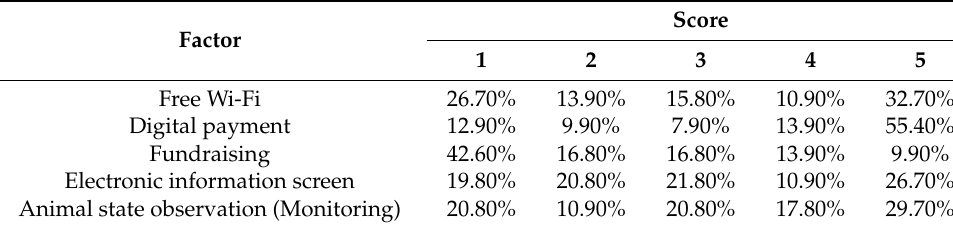
Table 13. Results (Performance) of the second-level questionnaire (Smartphone website application(s)). Factor